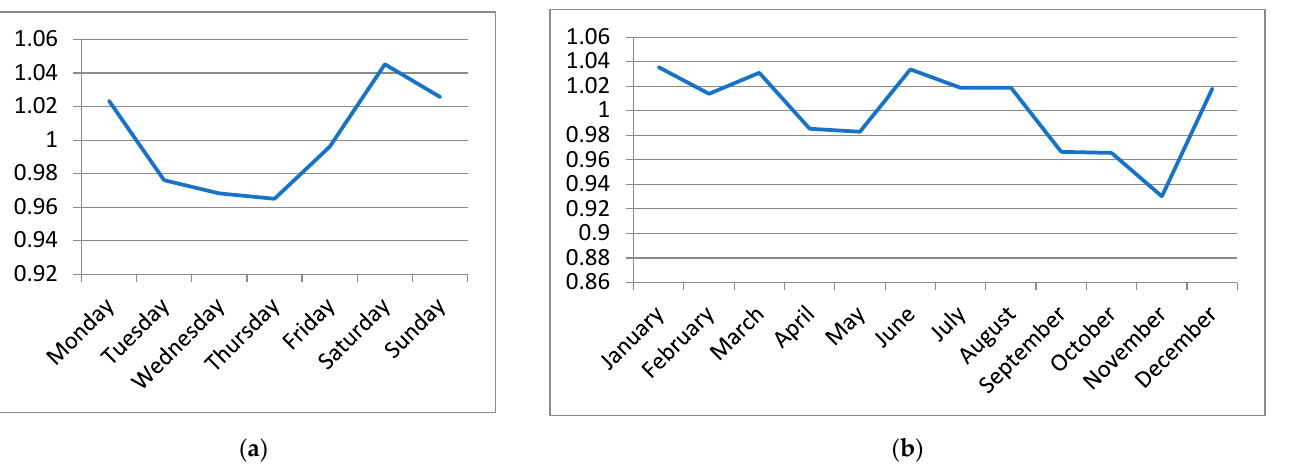
Figure 1. ( a ) The ratio of the number of trips on individual days to the daily average in 2019; ( b ) The ratio of the number of trips in individual months to the monthly average in 2019.